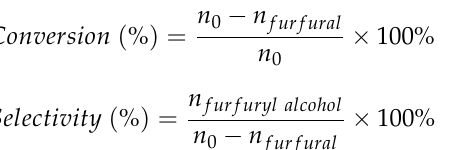
Figure S8: HPLC standard curves of furfuryl alcohol and